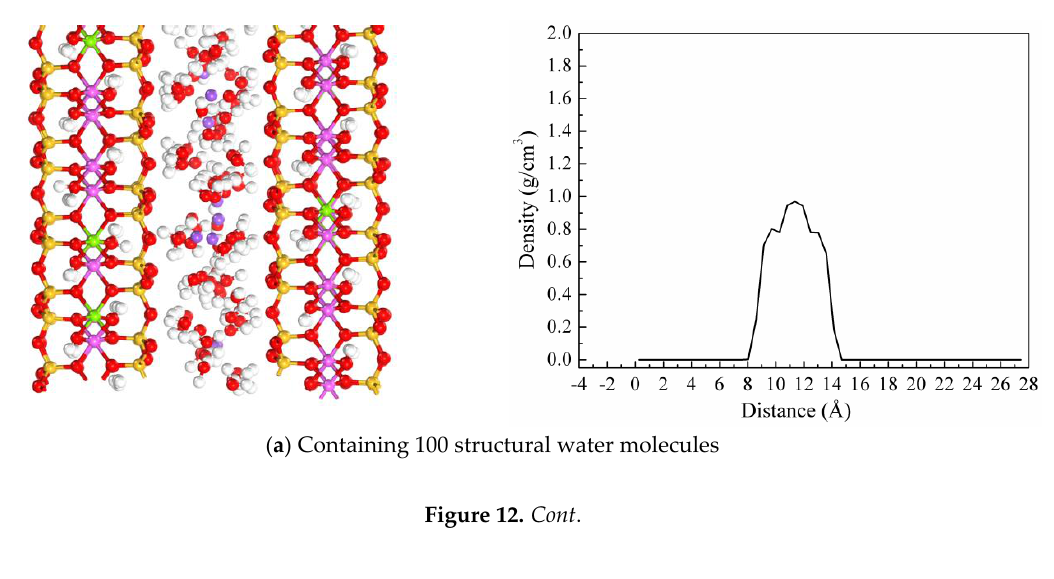
Figure 11. Swelling curve of montmorillonite: d -spacing as a function of the number of structural water molecules.